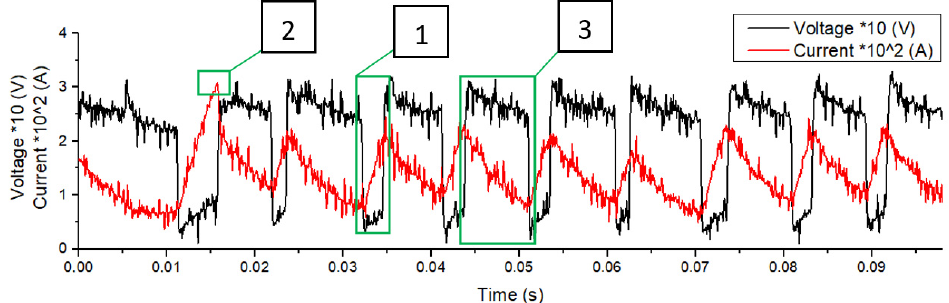
Figure 2. Process oscillogram, 1—short circuit, 2—peak current, 3—arc burning.